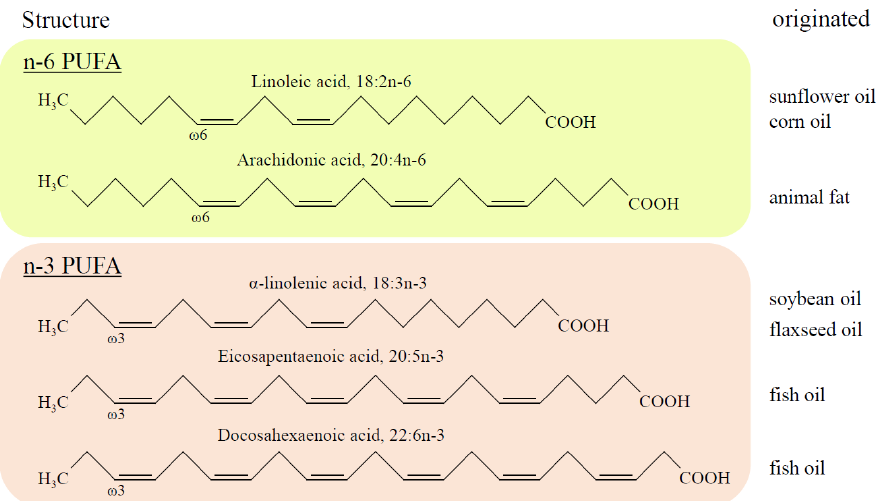
Figure 1. The structure of polyunsaturated fatty acids (PUFAs) and originated oils. The